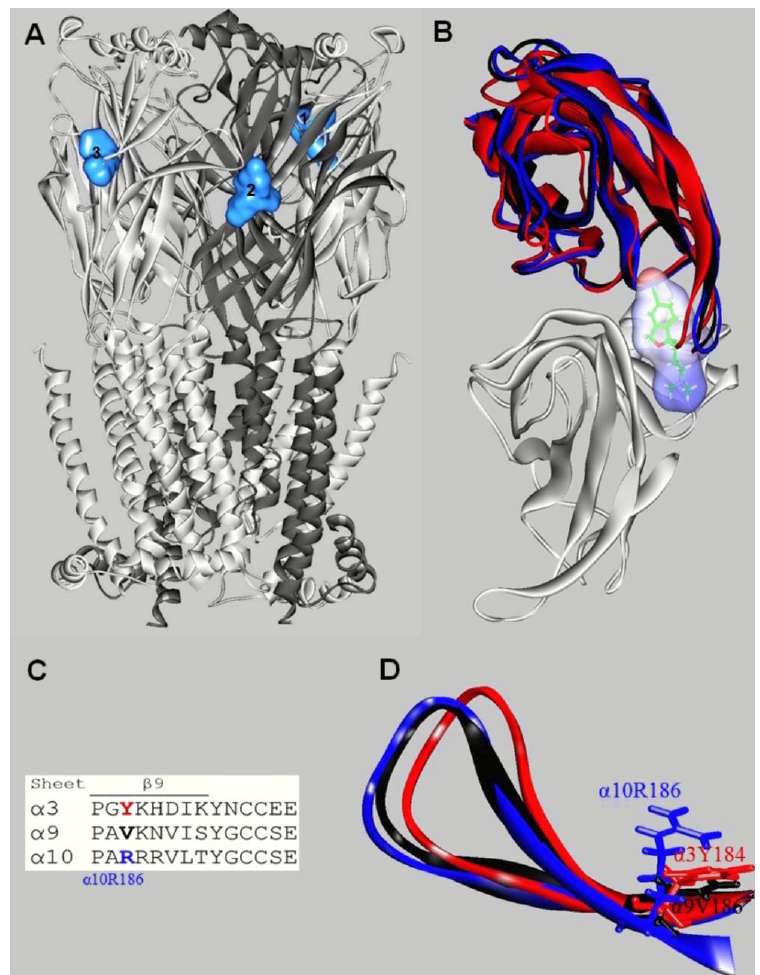
Figure 5. Docking sites for S-(+)-citalopram (escitalopram) in the h(α9)2(α10)3 nAChR model (modified from [68]). ( A ) Escitalopram (light blue surface model) interacted with three possible orthosteric sites located at the interface between the α10(+) (principal component) and α9(-) (or another α10(-)) (complementary component) subunits. The α10 (white) and α9 (dark gray) subunits are represented as solid ribbons. ( B ) Orthosteric binding sites at the superposed α3(+) (red), α9(+) (black), α10(+) (blue), and α9(-) (white) subunits. Escitalopram is shown as sticks surrounded by the molecular surface. The β9-β10 loop at the α3 and α9 subunits is closer to the receptor center than that at α10, and consequently, there is no room for escitalopram to fit in the agonist binding site in α3 and α9. The α3- and α9-β9-β10 loops overlap the ligand when it is docked as in the α9α10 receptor. ( C ) Amino acid sequence comparison between α3, α9, and α10 subunits at the level of the β9-β10 loop. Blue: Amino acids identified as causing different β9-β10 loop conformations. ( D ) Side-chain view showing differences in the occupied volume of side chains at the α10-R186, α9-V186, and α3-Y184 positions, respectively. The side-chain volume differences in the β9-sheet would force the α10-β9-β10 loop to be set apart from the binding pocket. So far, this is the only nAChR subtype where the SSRI-induced inhibition is medi- ated by a competitive mechanism. The orthosteric sites for escitalopram are located at the interface between α10(+) (principal component) and α9(−) or another α10(−) (comple- mentary component), but not at the α9(+) and α10(-) interface [68]. To study these inter- actions in more details, in silico mutations were performed on key residues at the or- thosteric binding site, transforming α9α10 into α3β4 and vice versa. The docking results indicated that the mutations did not abolish escitalopram binding to the α9α10 mutant or